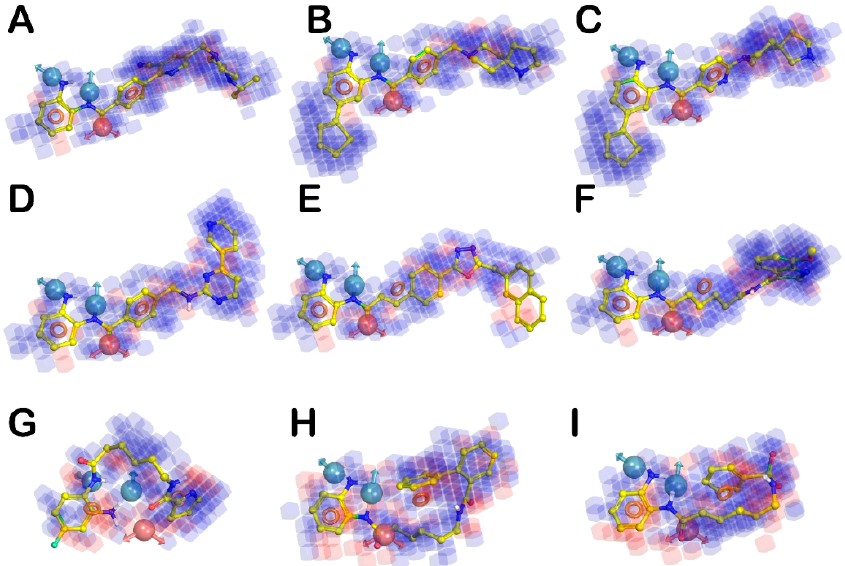
Figure 5. ( A – C ) Superposition of highly active compounds 3 , 10 , and 13 , respectively with the 3D- QSAR model. ( D – F ) Superposition of moderate active compounds 22 (Mocetinostat), 213 , and 239 , respectively with the 3D-QSAR model. ( G – I ) Superposition of less active compounds 218 , 279 , and